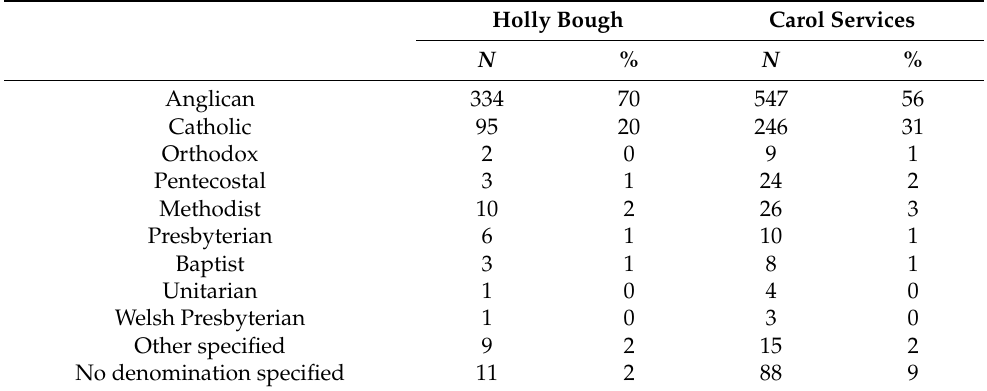
Table 9. Christian denomination.